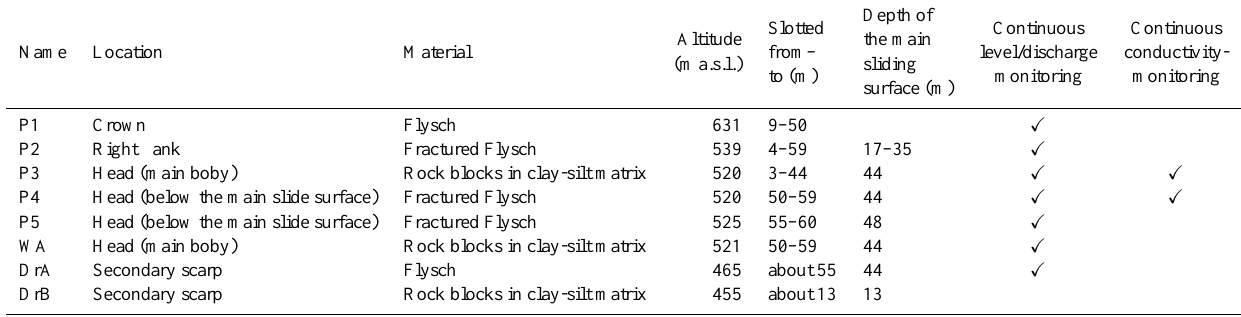
Table 1. Characteristics of piezometers, wells and drainage systems in Ca’ Lita landslide. Location in the landslide area, material, depth of the filters, depth of the main slide surface, type of monitoring are also reported. Name